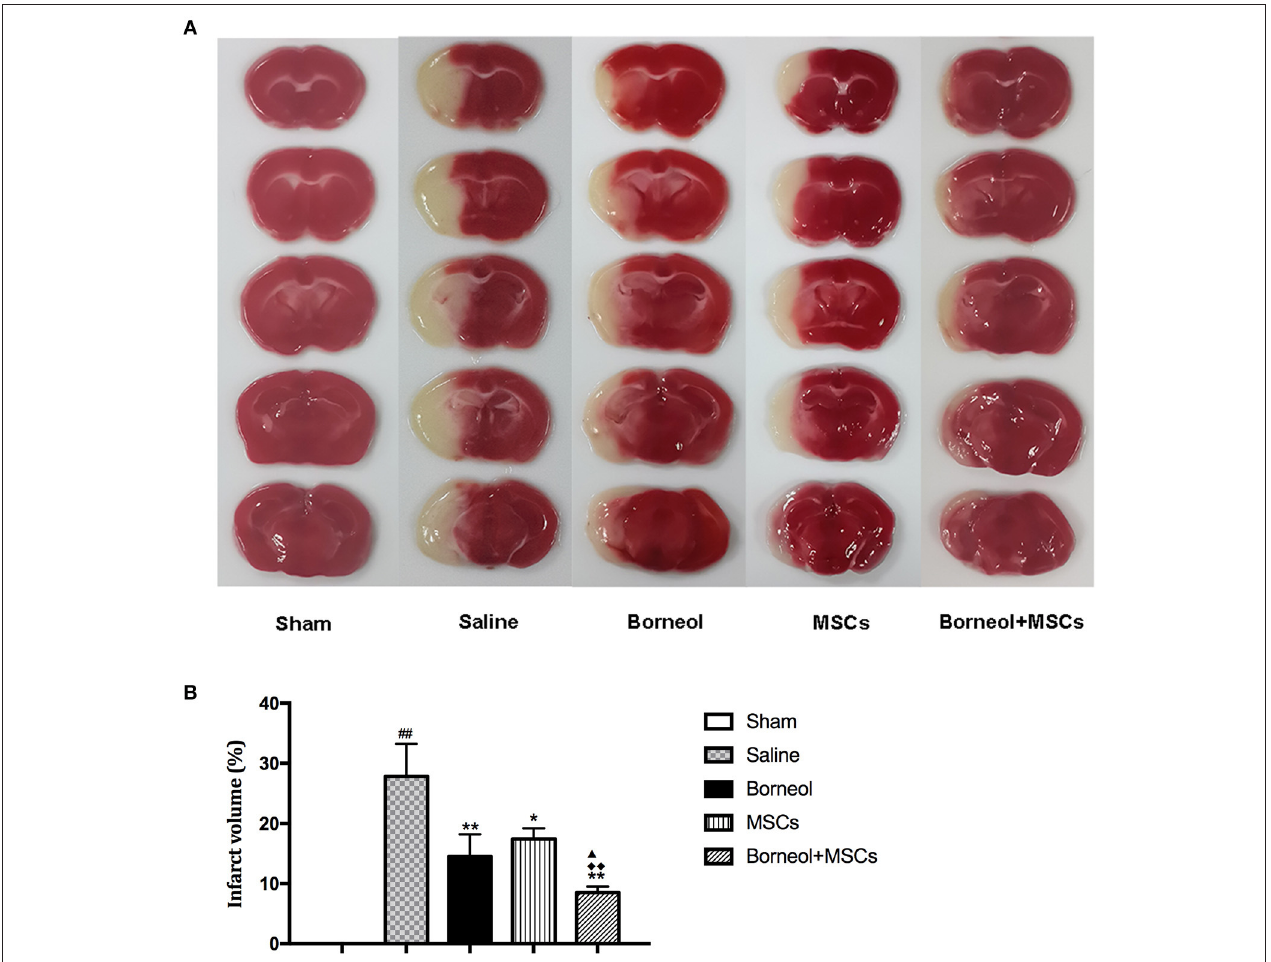
FIGURE 4 | Effect of borneol and MSCs transplantation on infarct volume at 7 d after MSCs transplantation. (A) TTC-stained brain slices from sham, MCAO plus saline, borneol, MSCs, and borneol plus MSCs group. (B) Quantitative analysis of infarct volume. Data were expressed as mean ± SD . ## P < 0.01 compared with sham group; * P < 0.05, ** P < 0.01 compared with MCAO plus saline group; N P < 0.05 compared with borneol group; (cid:7)(cid:7) P < 0.01 compared with MSCs